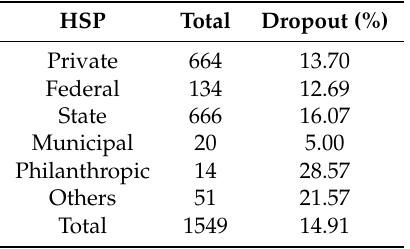
Table 4. High school provenance (HSP) and the corresponding number of observed samples and dropout